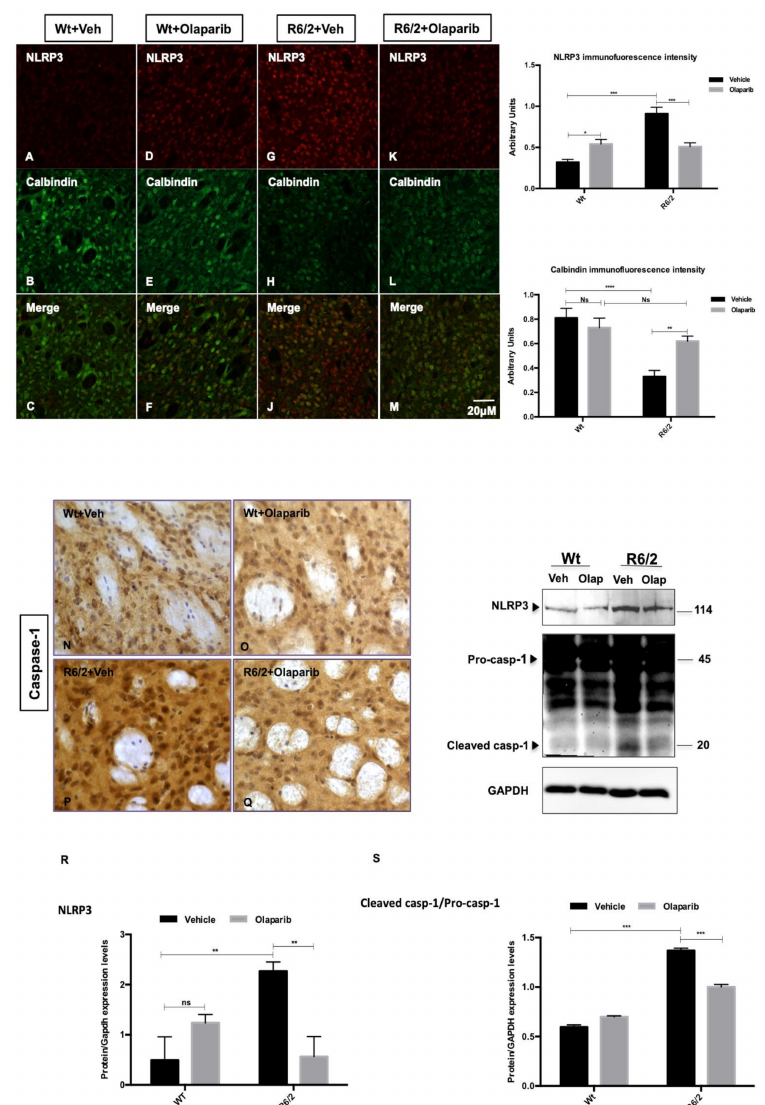
Figure 4. E ff ects of Olaparib on the expression / activation of inflammasome-mediated caspase-1 in R6 / 2 mice. ( A – M ) Collected images show the immunoreaction intensity relative to NLRP3 in each animal group at the di ff erent time points. Two-Way ANOVA analysis performed on data obtained by all animal groups showed a statistically significant e ff ect of Genotype (F 1,30 = 32.56; p < 0.001), Treatment (F 1,30 = 26.58; p < 0.001), and Genotype X Treatment Interaction (F 1,30 = 2.746; p < 0.001) of NLRP3 positive striatal neurons. Histogram shows NLRP3 intensity quantification, which is significantly decreased in the striatal neurons of Olaparib-treated R6 / 2 mice (treatment e ff ect F 1,68 = 5.13; p < 0.01) compared to vehicle group. ( N – Q ) Representative transmitted light microscope images showing Dab staining for caspase-1 contour stained with hematoxilin in the striatum of vehicle or Olaparib-treated Wt and R6 / 2 mice. ( R , S ) Two-way ANOVA performed on densitometric analysis of the cleavage product of caspase-1 revealed a statistically significant e ff ect of Genotype (F1,68 = 1129.9; p < 0.001), Treatment (F 1,68 = 6810; p < 0.001), and Genotype X Treatment Interaction (F1,68 = 41.34; p < 0.001) in the R6 / 2 group treated with Olaparib compared to the vehicle